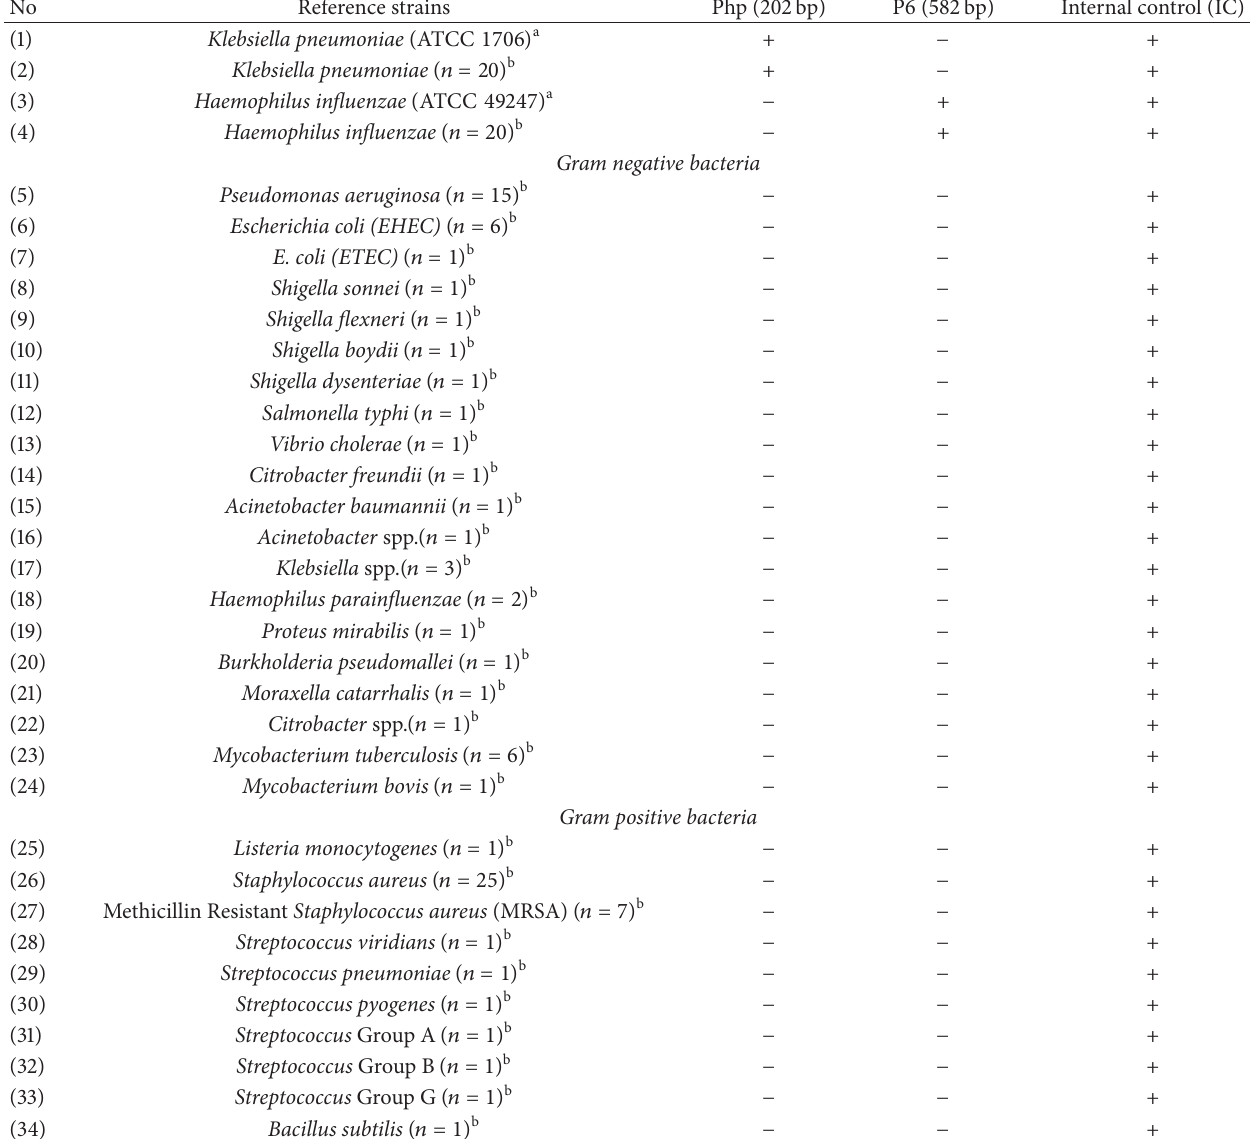
Table 1: Bacterial species and strains used in this study and results of the thermostabilized